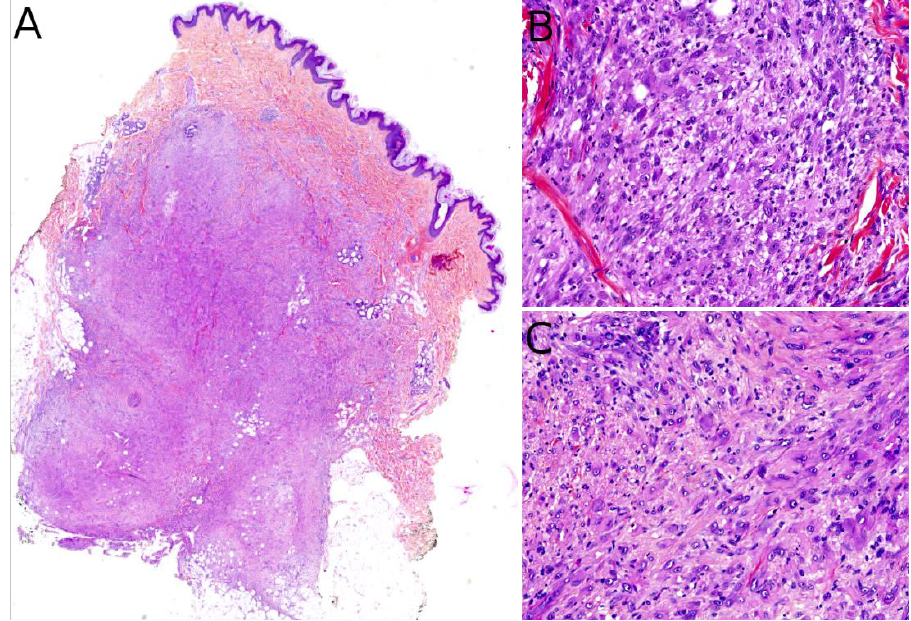
Figure 9. Pseudomyogenic hemangioendothelioma: ( A ) Dense cellular proliferation with an infil- trating pattern of growth (×25); ( B ) sheets of epithelioid cells or plump spindle cells with a deeply eosinophilic cytoplasm (×100); ( C ) rhabdomyoblast-like cells with moderate nuclear atypia and some neutrophils in the stroma (×200).